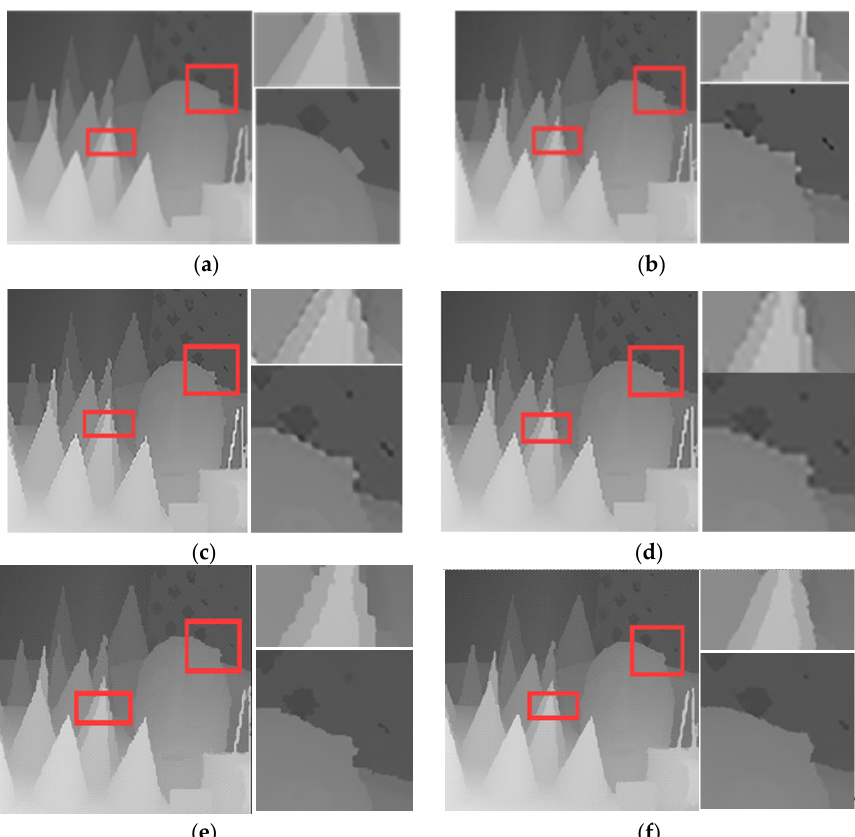
Figure 5. Visual comparisons of “cones”: ( a ) ground truth (reprinted with permission from [37]); ( b ) Kim [25]; ( c )AANR [7]; ( d ) Zeyde [6]; ( e ) Xie [8]; and ( f ) our